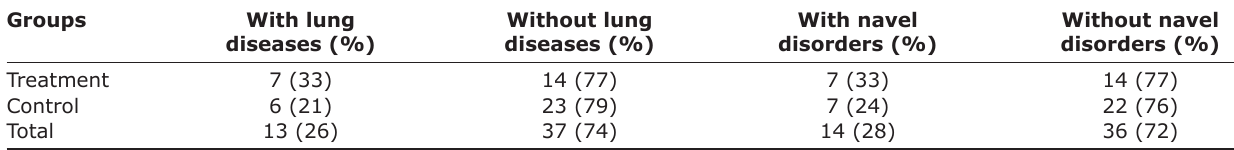
Table-1: Comparison of the frequency of lung and navel diseases between the treatment and the control groups on days 1 and 10 postpartum (There were no statistically significant differences in the lung disease and navel findings between the